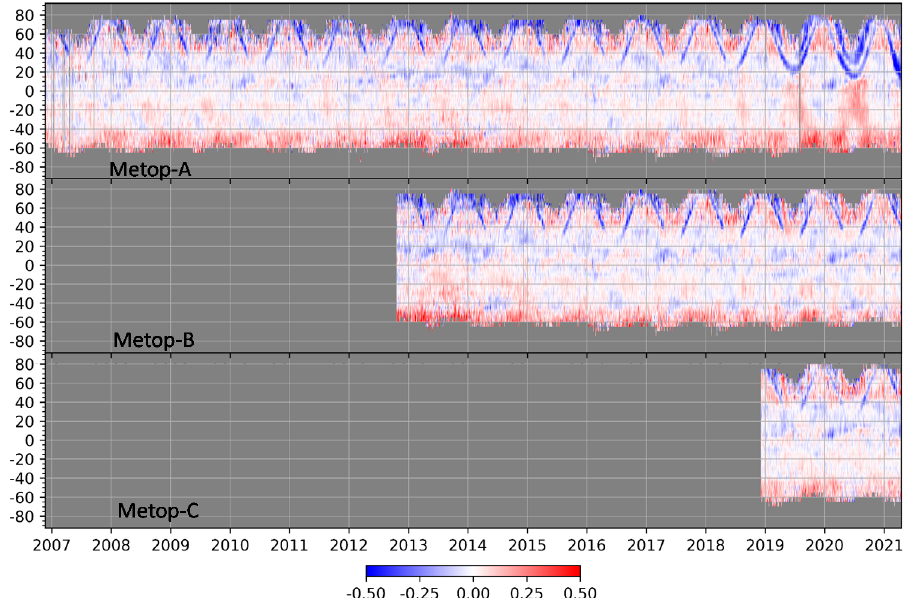
Figure 19. Hovmöller diagrams of 24hr aggregated latitudinal biases in nighttime GR – (D+TM) SST for the full Metop-FG missions.